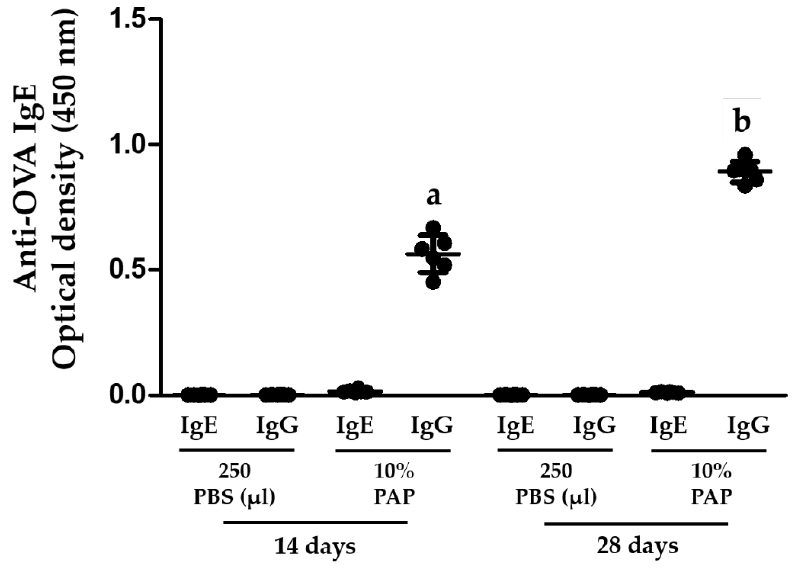
Figure 5. Comparison of the 14- and 28-day protocols to trigger an anti-PAP IgE and IgG antibody response in BALB/c mice. Groups of mice (n = 6) were injected ip with 250 µ L of 10% PAP. Blood samples were collected either 14 (2 injections) or 28 (5 injections) days after the first injection. The presence of anti-PAP IgE and IgG antibodies was evaluated using ELISA. Different letters mean statistical differences ( p < 0.05) by unpaired t test.